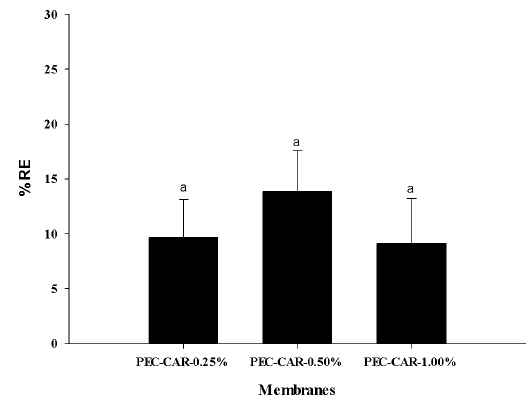
Figure 5. Encapsulation efficiency (%) in PEC-CAR membranes. *Duncan´s multiple comparison test: different letters by column indicate significant differences ( p <